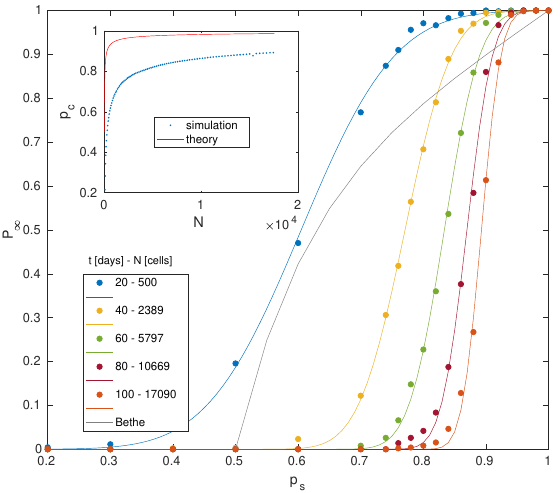
Figure 6: Probability of percolation as a function of p s for different colony sizes. Dots correspond to sim- ulations and lines are theoretical fittings to estimate the percolation threshold (see text). The gray line is the theoretical Bethe result. threshold p c at different sizes measured by simulations (blue). Our simple theoretical approach overestimates this threshold